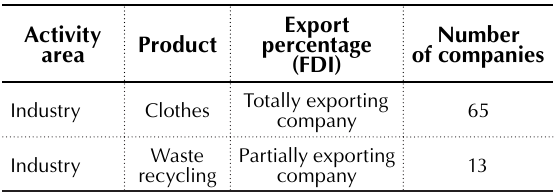
Table 1. Companies contributing to the CSR located in Tunisia